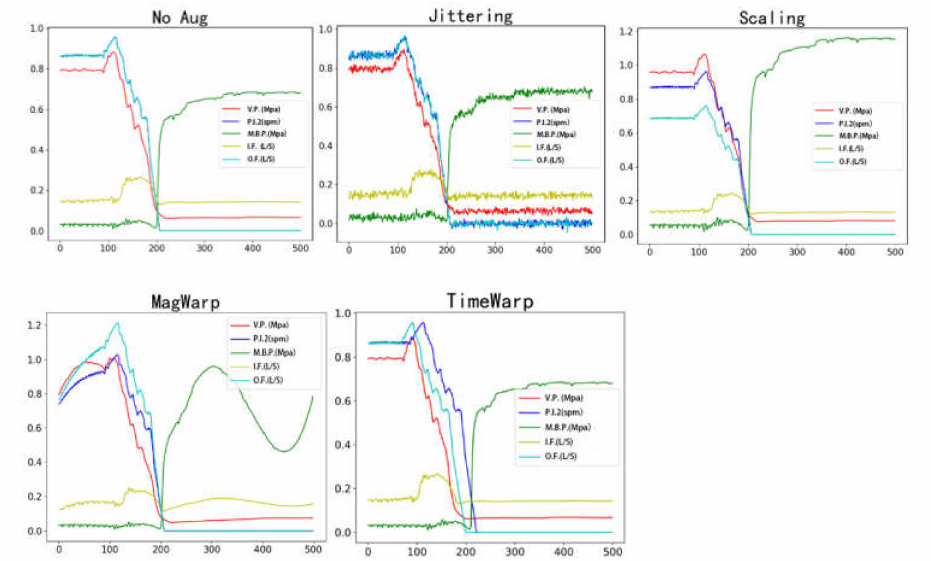
Figure 5. Enhancement effect of different time series. V.P. represents Stand Pipe pressure. P.I.2 represents Pump impulse. M.B.P. represents Wellhead pressure. I.F. represents Inlet flow. O.F. represents Outlet